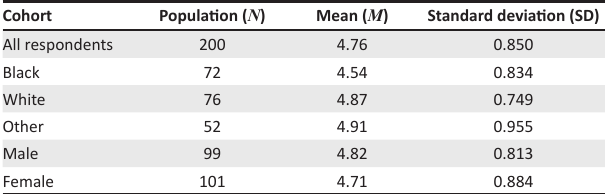
TABLE 6: Overall service quality perception mean scores and standard deviations ( N = 200).